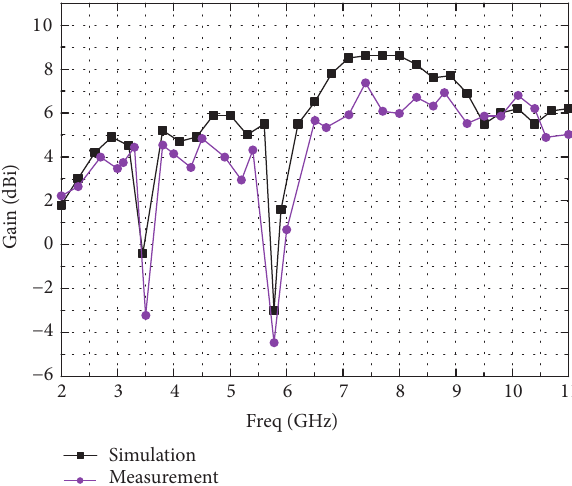
Figure 16: Simulated and measured gain of the antenna.